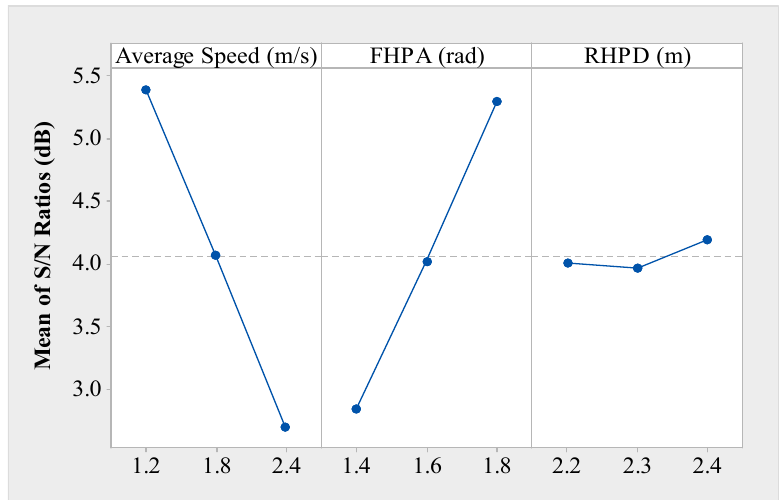
Figure 4. Mean S/N ratio trend for A(8). (FHPA: front harrow pin angle; RHPD: rear harrow pin distance; S/N: signal to noise ratio).